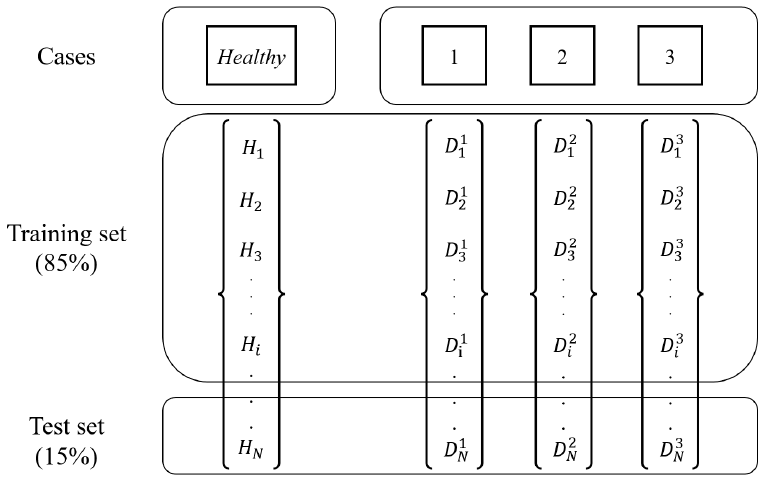
Figure 5. Format of the dataset.